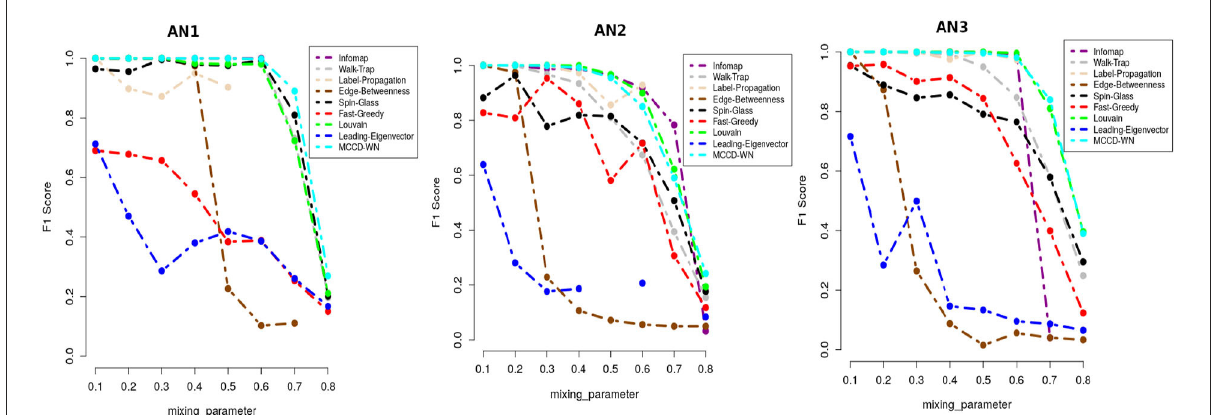
FIGURE5 Performance comparison in terms of F1-score.